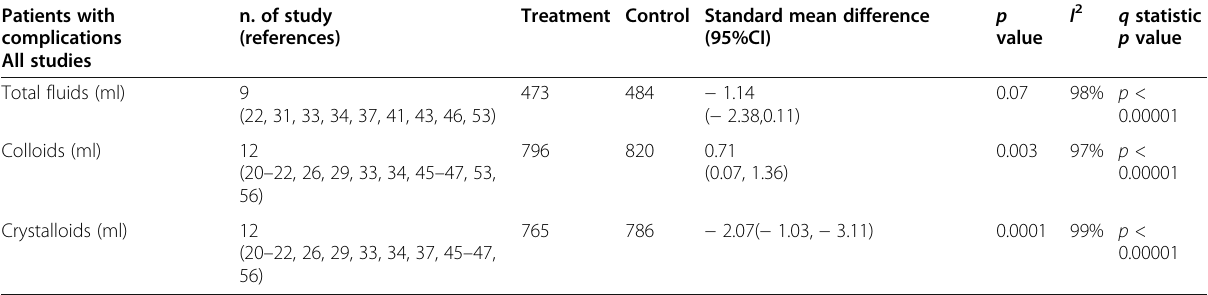
Table 4 Total amount of fluids, colloids, and crystalloids used in all RCTS included Patients with